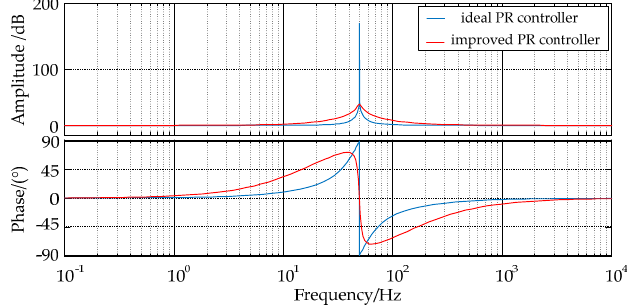
Figure 7. Bode diagram of PR controller and improved PR controller.